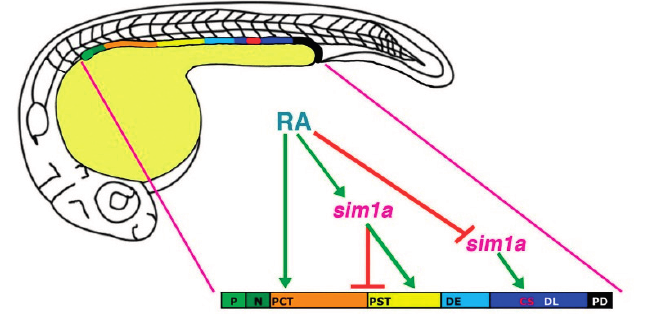
Figure 5. Model of sim1a functions in nephron segmentation. sim1a is necessary to promote PST and CS formation and inhibit PCT fates during segment patterning in the zebrafish pronephros. These activities occur downstream of RA signaling, which promotes PCT and PST formation and expression of sim1a in these respective renal progenitor domains. Further, RA signaling inhibits sim1a expression in CS progenitors, placing it as a negative regulator upstream of sim1a during establishment of the CS